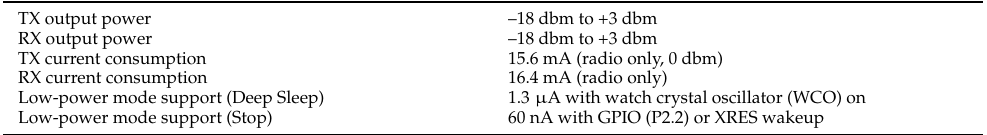
Table 2. Power consumption characteristics of the module CYBLE-012012-1.